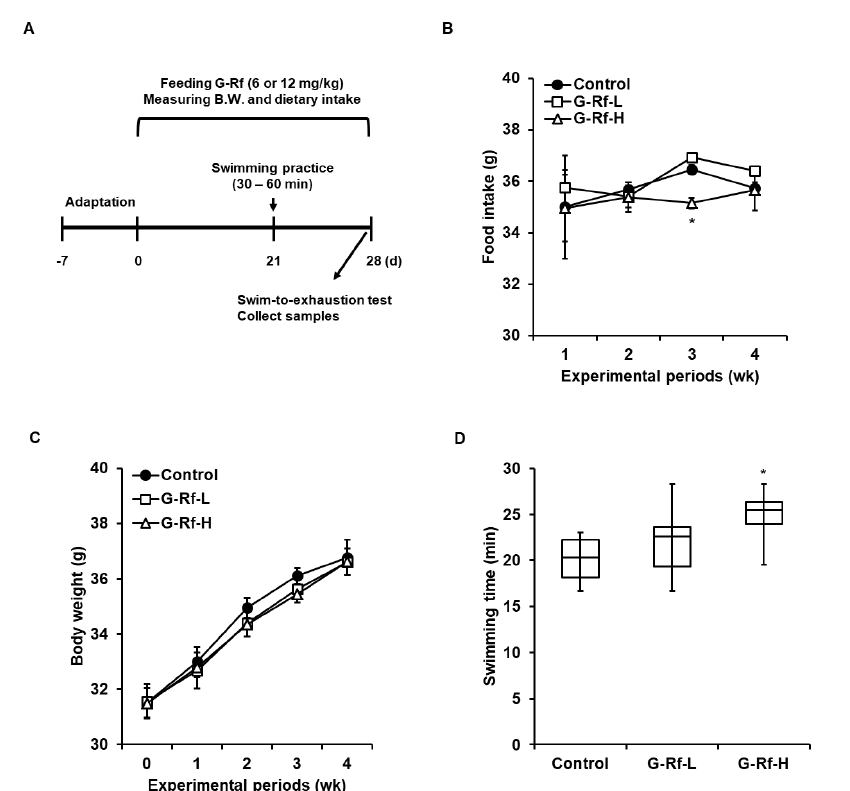
Figure 1. G − Rf enhances forced exercise endurance in ICR mice. ( A ) Schematic of animal experiments related to the forced swimming test. Mice were orally administered G − Rf dissolved in water (6 or 12 mg/kg) daily for 4 wk. The control group was administered the equivalent volume of water. ( B ) Food intake and ( C ) body weight were measured every week for 4 wk. ( D ) Swimming duration was recorded until mice did not rise above the water within 7 s due to exhaustion. Data are expressed as the mean ± standard deviation ( n = 8). * p < 0.05 compared to the control group.